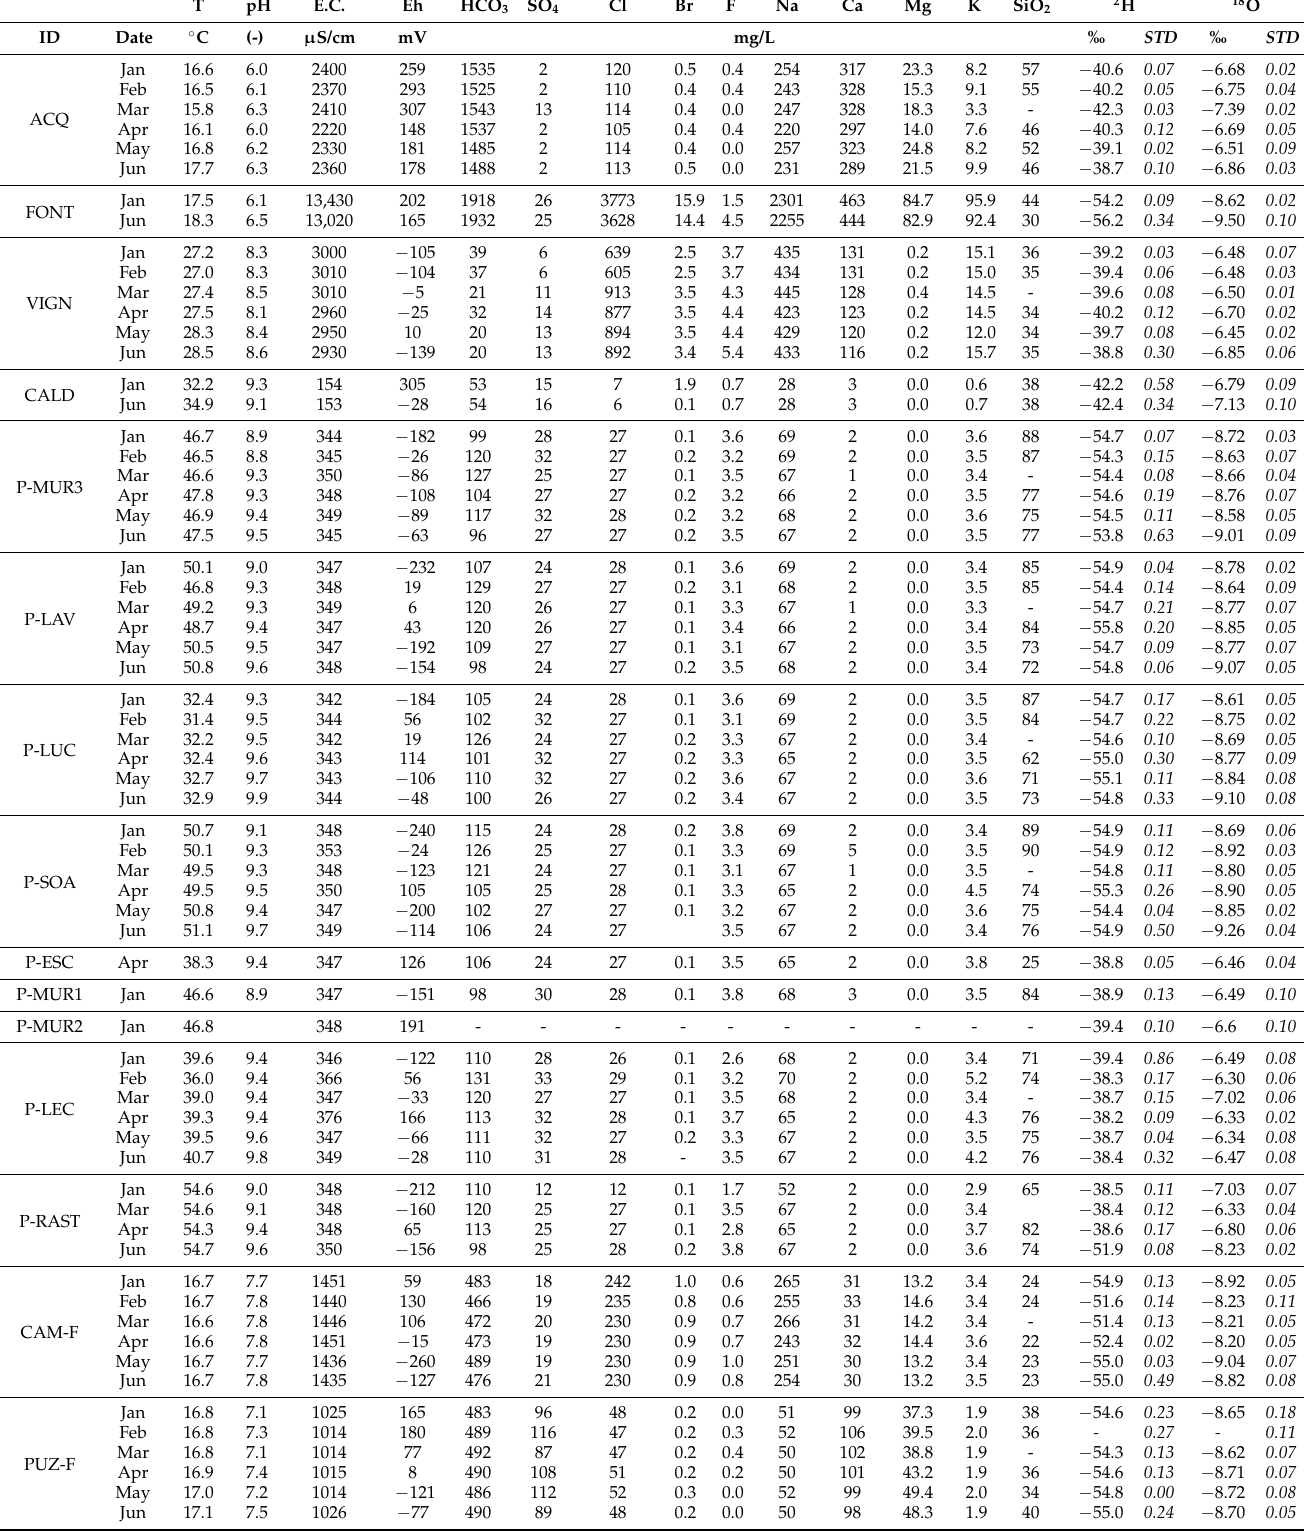
Table 2. Physico-chemical parameters and concentration in major chemical constituents (mg/L) as well as water stable isotopes values for mineral and thermal waters. (-)